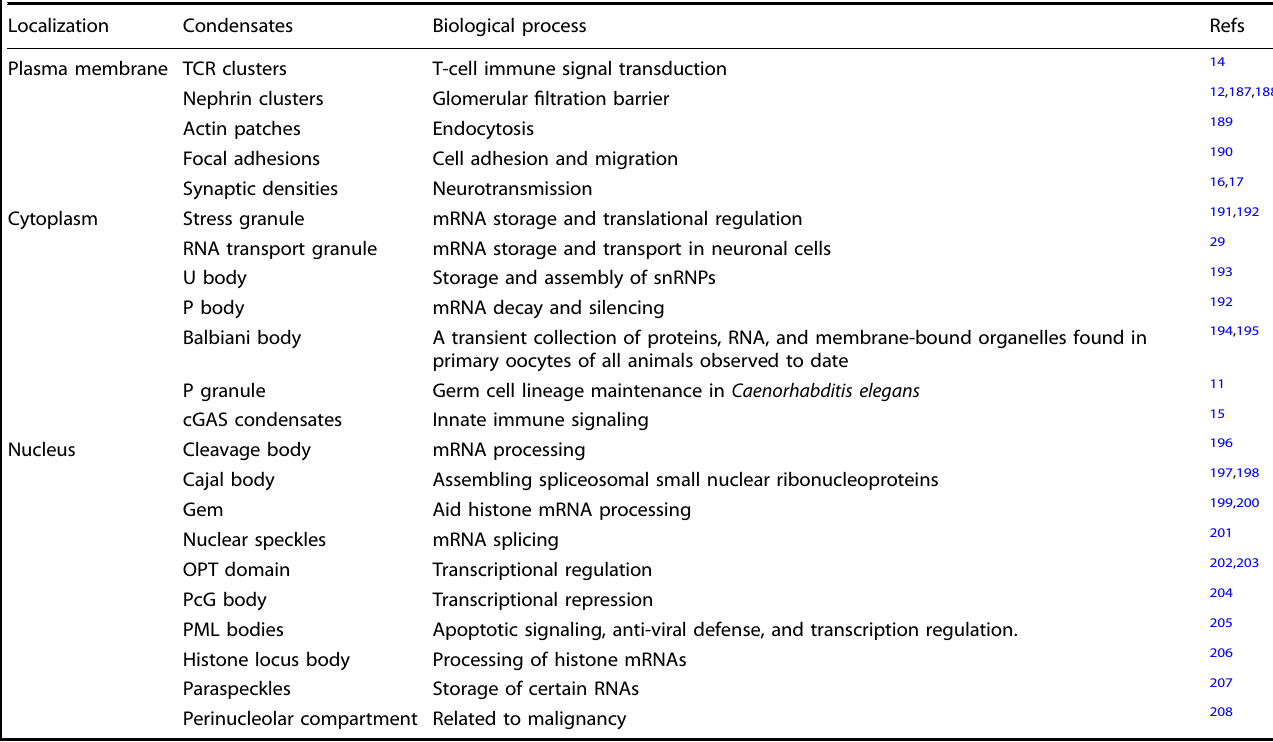
Table 1. Examples of the various biomolecular condensates and their functions